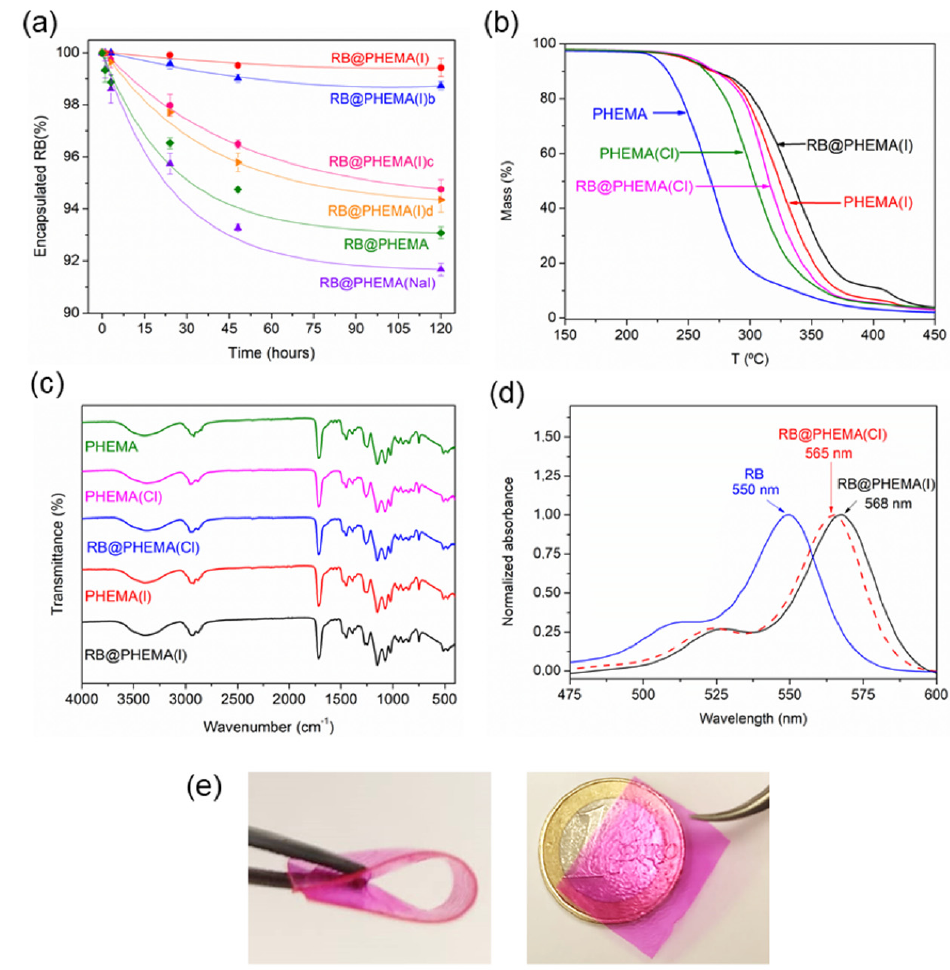
Figure 2. Characterization of PHEMA Films Described in this Study: ( a ) leaching of RB; ( b ) TGA curves; ( c ) ATR-FTIR spectra; ( d ) UV-vis absorption and ( e ) representative pictures of polymer